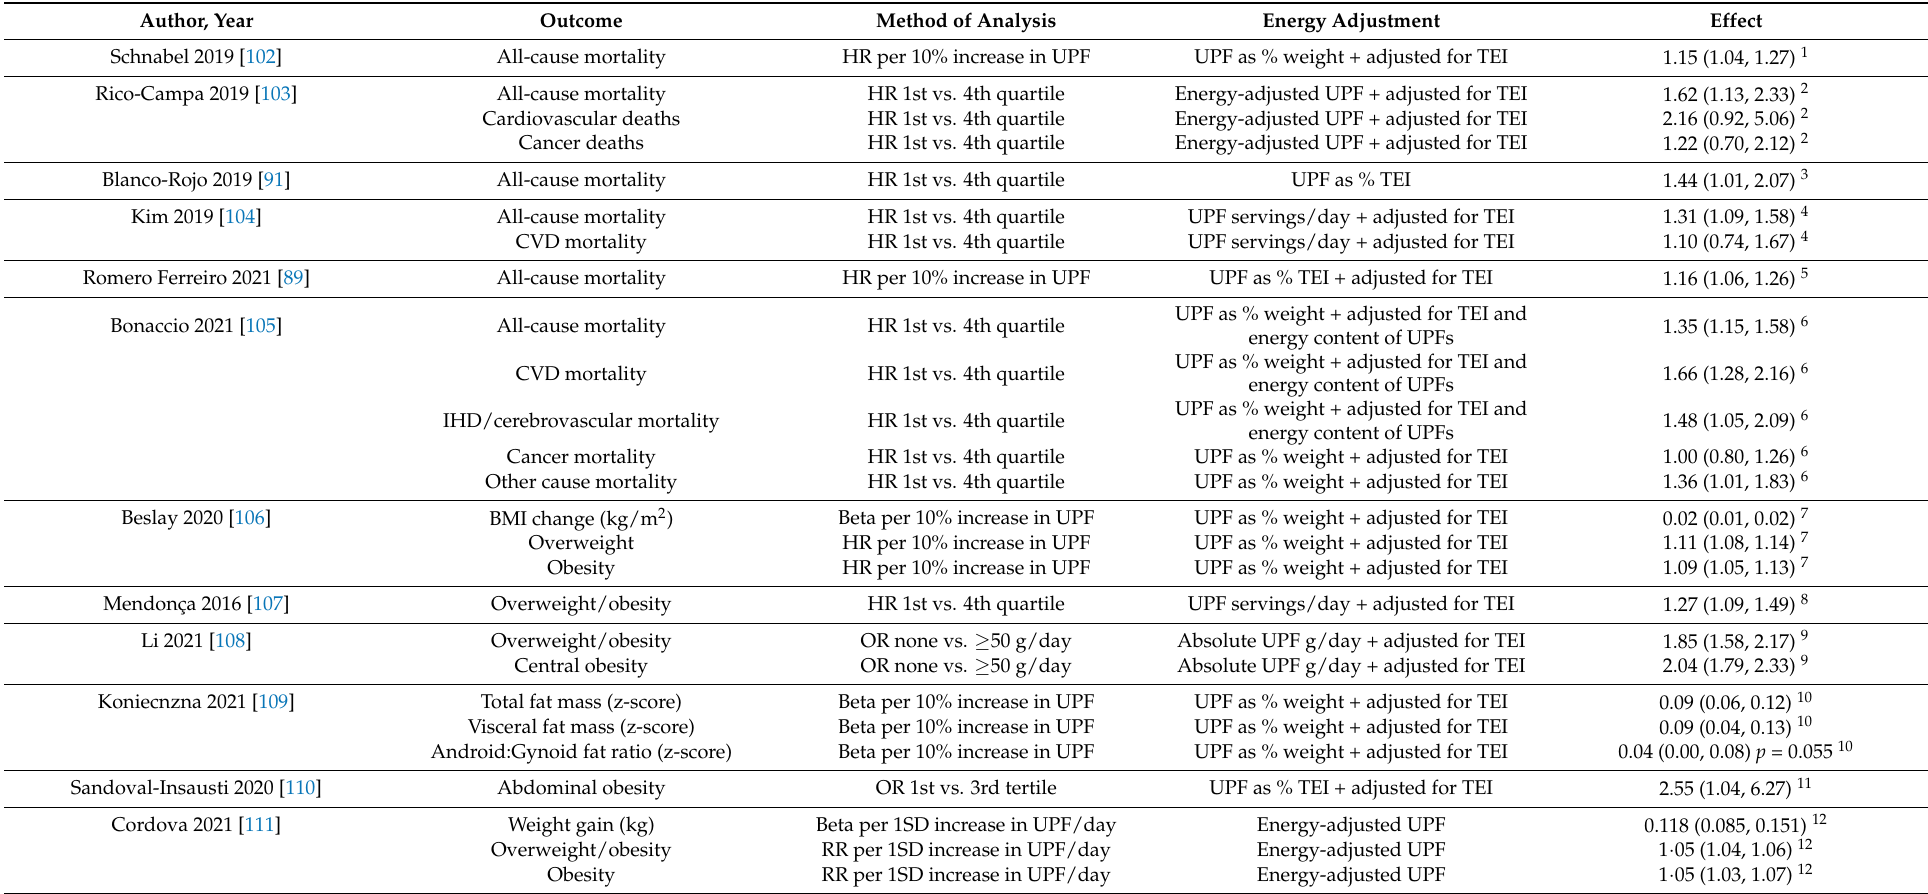
Table 5. Prospective cohort studies adjusting for total energy